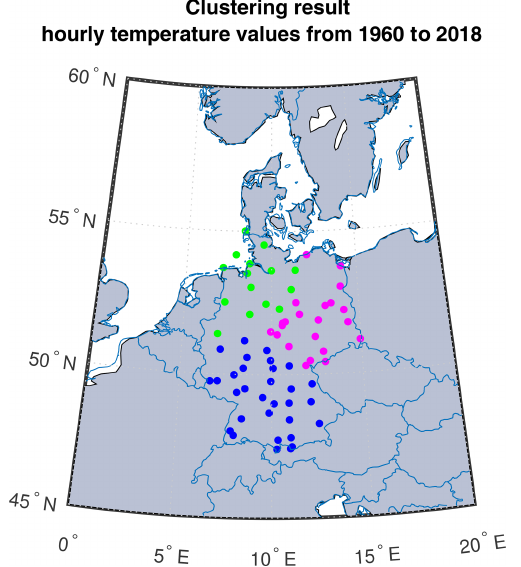
Figure 3. Clustering result for the hourly temperature network with similarity defined by NMMI over the time interval from 1960 to